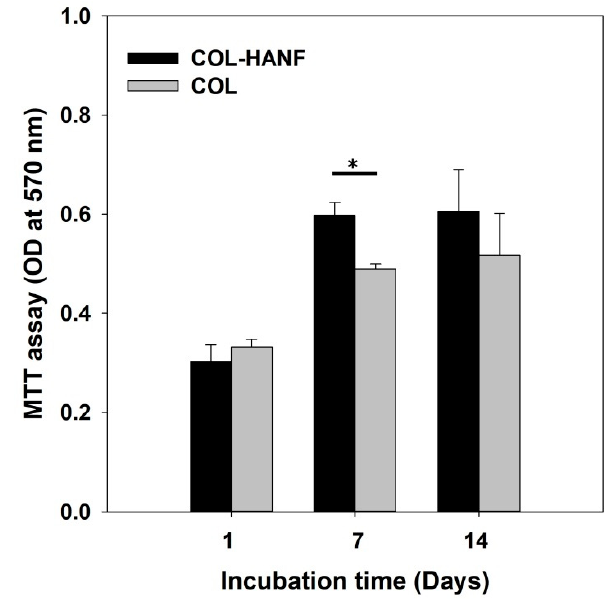
Figure 8. Proliferation of MG63 cells on the COL and COL-HANF scaffolds for up to 14 days of culture. Data are presented as the mean ± SD, n = 3. (*) denotes a significant difference (p < 0.05) between the COL scaffold and the COL-HANF scaffold.